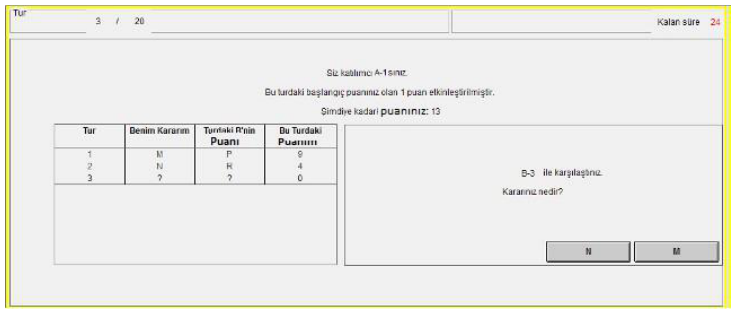
Figure A1. Type A’s Screen